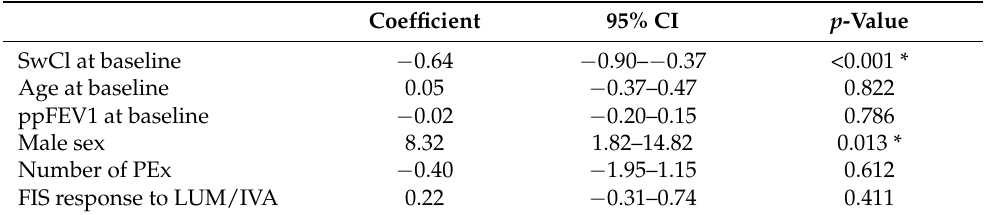
Table 4. Multivariable linear regression model of absolute change in SwCl after LUM/IVA ( n = 88).